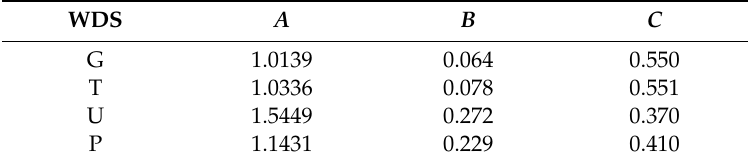
Figure 7. Cumulative out ‐ degree distribution functions for P WDS, with stretched exponential fitting. Table 3. Values of the coefficients obtained from the stretched exponential fitting.